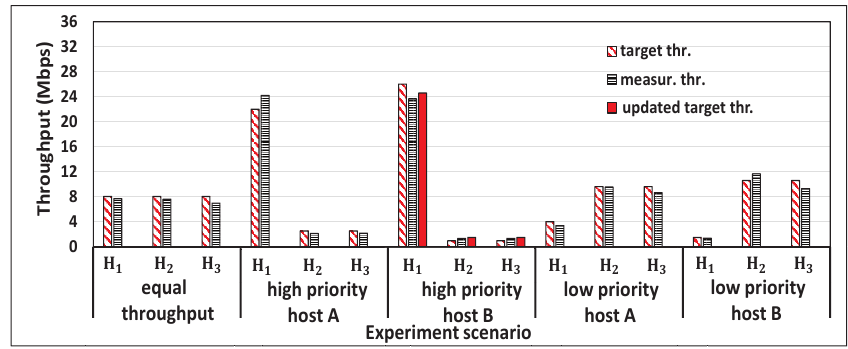
Figure 6. Results for two hosts case with a proposal.